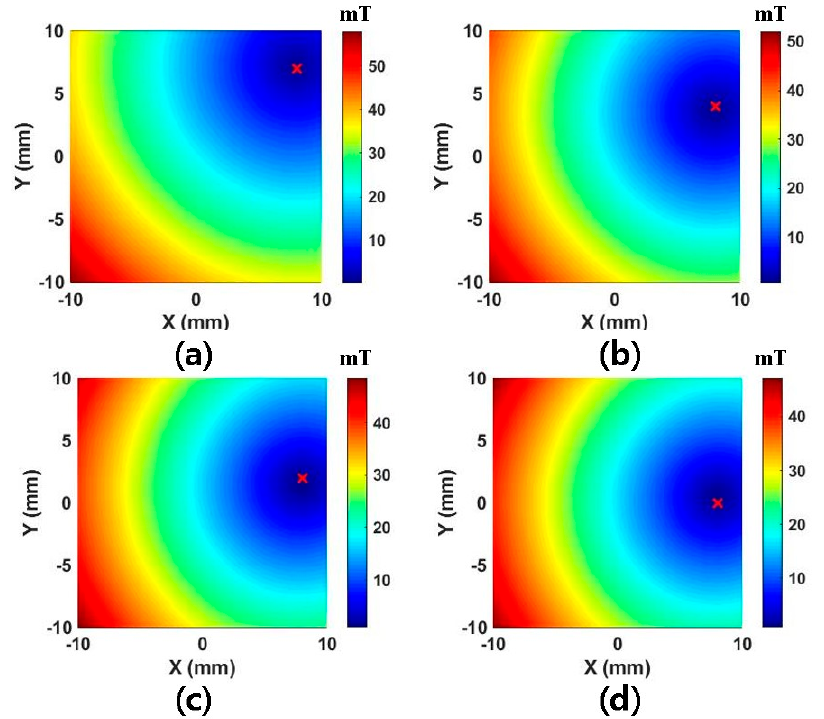
Figure 3. The desired FFP location is assumed to be (8,0). ( a ) The FFP field mapping corresponding to a weight of 30. ( b ) The FFP field mapping corresponding to a weight 50. ( c ) The FFP field mapping corresponding to a weight of 90. ( d ) The FFP field mapping corresponding to a weight of 141. The position corresponding to the minimum value (red mark in each field map) is at (8,7) in ( a ), (8,4) in ( b ), (8,2) in ( c ), and (8,0) in ( d ).